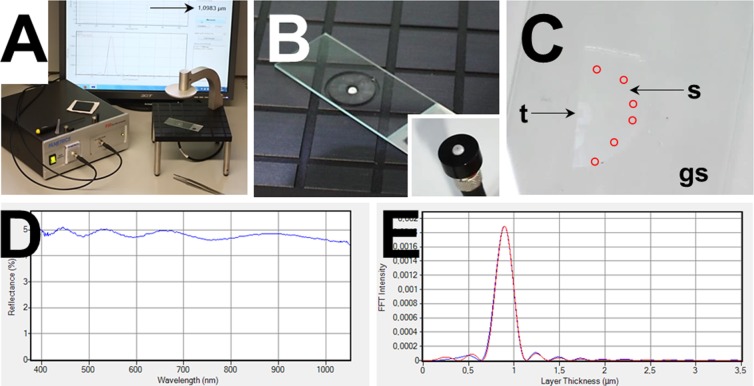
Spectral reflectance section thickness measurement.Thicknesses of unstained GMA/MMA or Epon sections mounted on borosilicate glass slides were measured with a F20 optical reflectometer (Filmetrics®, USA) using the “contact stage” mode. The glass slide is placed on the stage with the mounted section facing the opening of the fiber optic cable (A, B). The opening of the fiber optic cable (inset to B) has a diameter of ~250 μm. (C) Detail enlargement of one half of a GMA/MMA section (s, arrow) mounted on a glass slide (gs) for spectral reflectance measurement of the section thickness (the second half is orthogonally re-embedded in Epon for verification of the section thickness by microscopic measurement). The tissue (t) present in the section is indicated (arrow). Per case, section thickness measurements were performed at six different locations (indicated by red circles) of the section, where no embedded tissue was present. Measurement details (D, E) and results are directly displayed at the monitor of the connected computer (A, arrow). (D) Reflectance spectrum. (E) Fast Fourier Transform (FFT)-intensity plot. The blue line on the graph represents the measured reflectance data, whereas the red line on the graph shows the calculated reflectance (based on the indicated refractive indices, extinction coefficients, and approximate thicknesses of the Epon-, or GMA/MMA sections and the borosilicate-glass slides). A successful measurement is indicated by an overlap of the wavelengths of the maxima and the minima of the calculated and the measured reflectance curve.